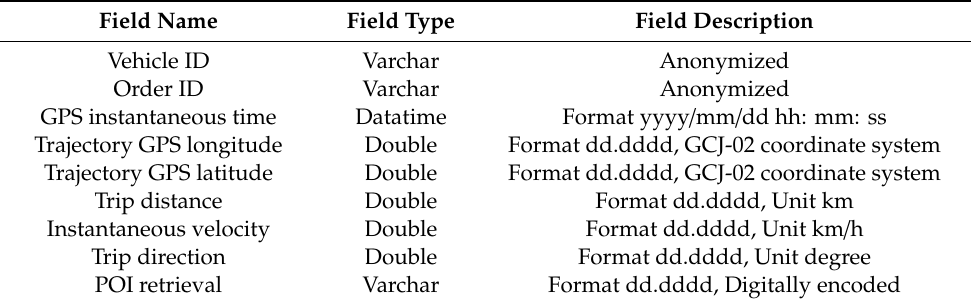
Table A1. Description of Didi trip data format.